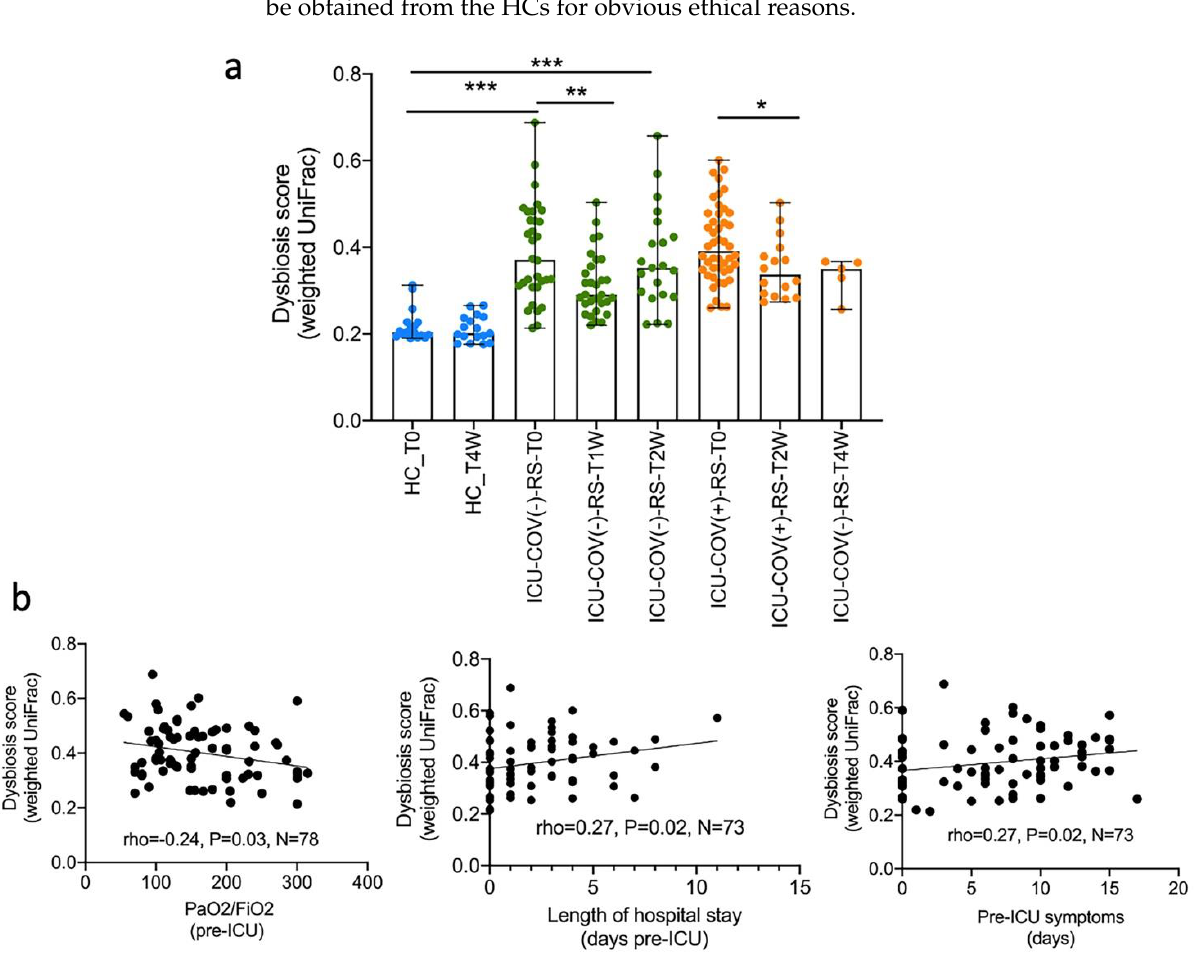
Figure 7. Dysbiosis scores calculated for each sample and association with clinical data. ( a ) Dysbiosis scores in critically ill patients were calculated based on the weighted UniFrac distance metrics of the 16S rRNA sequence data of rectal swab samples, using fecal samples of HCs as reference data. * p < 0.05, ** p < 0.001, *** p < 0.0001, Mann – Whitney test. ( b ) Correlation between dysbiosis scores and clinical data such as the PaO2/FiO2 ratio, length of ward stay before ICU, and duration of pre-ICU clinical symptoms (Spearman correlation test). The correlations were performed using rectal swab samples obtained at baseline for both ICU groups.